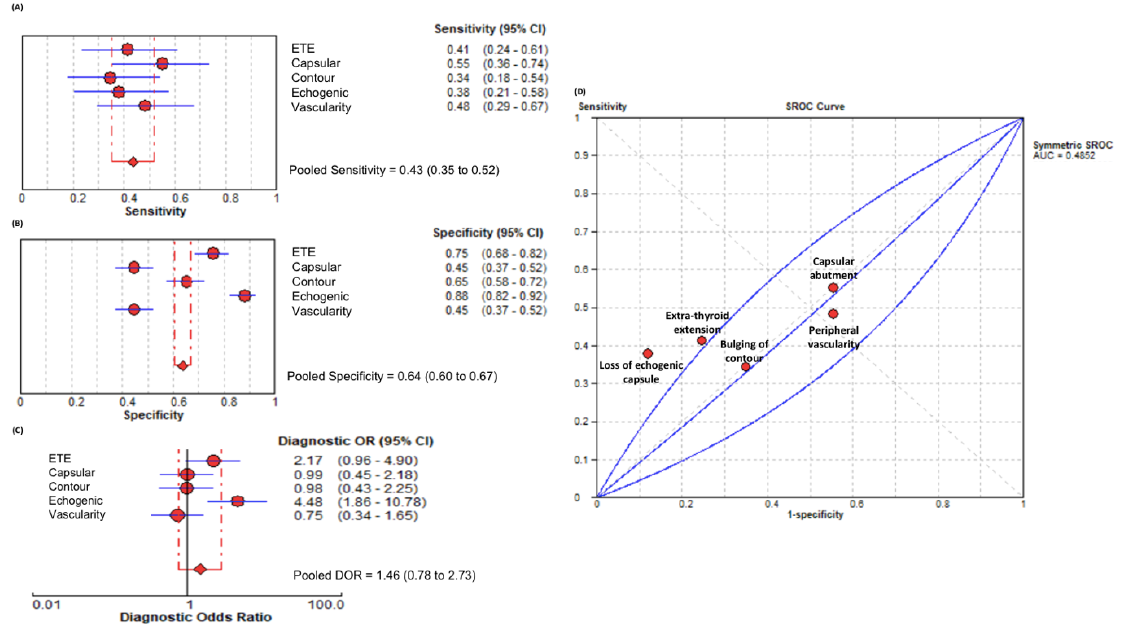
Figure 1. Pooled analysis of different sonographic features. The ( A ) sensitivity, ( B ) specificity, ( C ) diagnostic odds ratio, and ( D ) summary receiver operating curve are depicted. ETE: subjective suspicion of ETE, Capsular: abutment of the capsule, Contour: bulging of thyroid contour, Echogenic: loss of echogenic capsule, Vascularity: extension of vascularity beyond thyroid capsule. CI: confidence interval; DOR: diagnostic odds ratio; sROC: summary receiver operating curve; AUC: area under the curve.